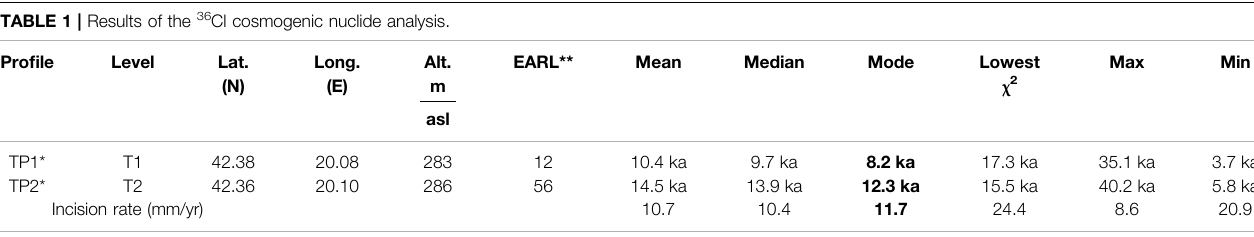
TABLE 1 | Results of the 36 Cl cosmogenic nuclide analysis. Pro fi le